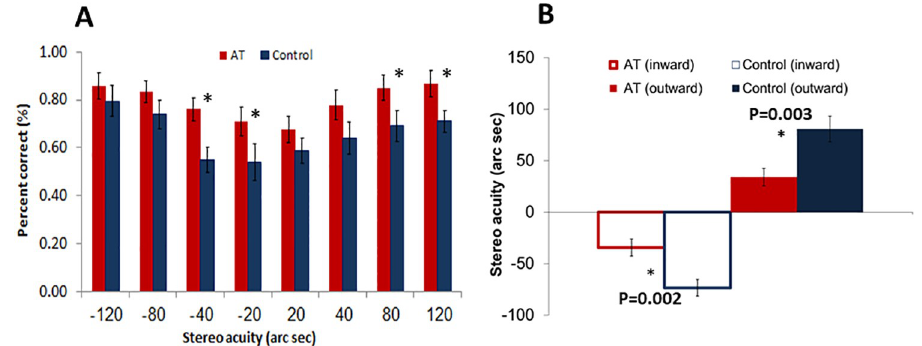
Fig 2. Stereo acuity performance: Stereo acuity in anomalous trichromat subjects and in normal color vision controls. (a) . Percent correct vs. stereo acuity in anomalous trichromats (red) and controls (blue). (b) . Stereo acuity threshold: "outward" (red—anomalous trichromats, blue—controls) and "inward" (vacant red—anomalous trichromats, vacant blue—controls). Error bars represent the standard error of the mean.